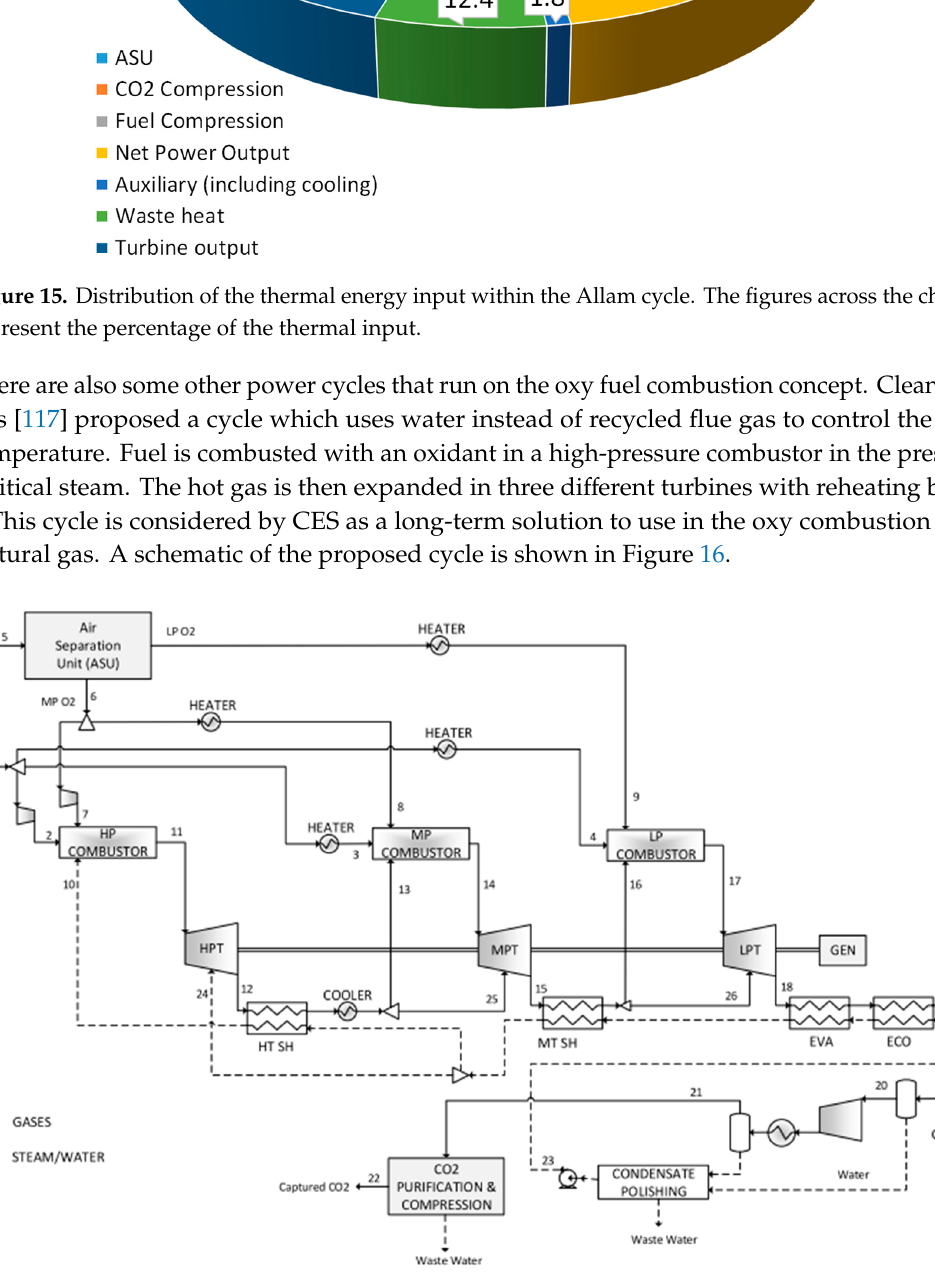
Figure 16. Schematic diagram of a supercritical CES cycle